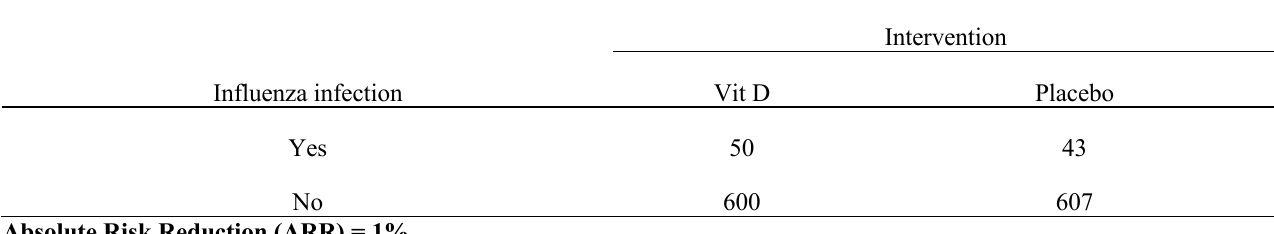
Table 4. Comparison of vitamin D and placebo on influenza infection